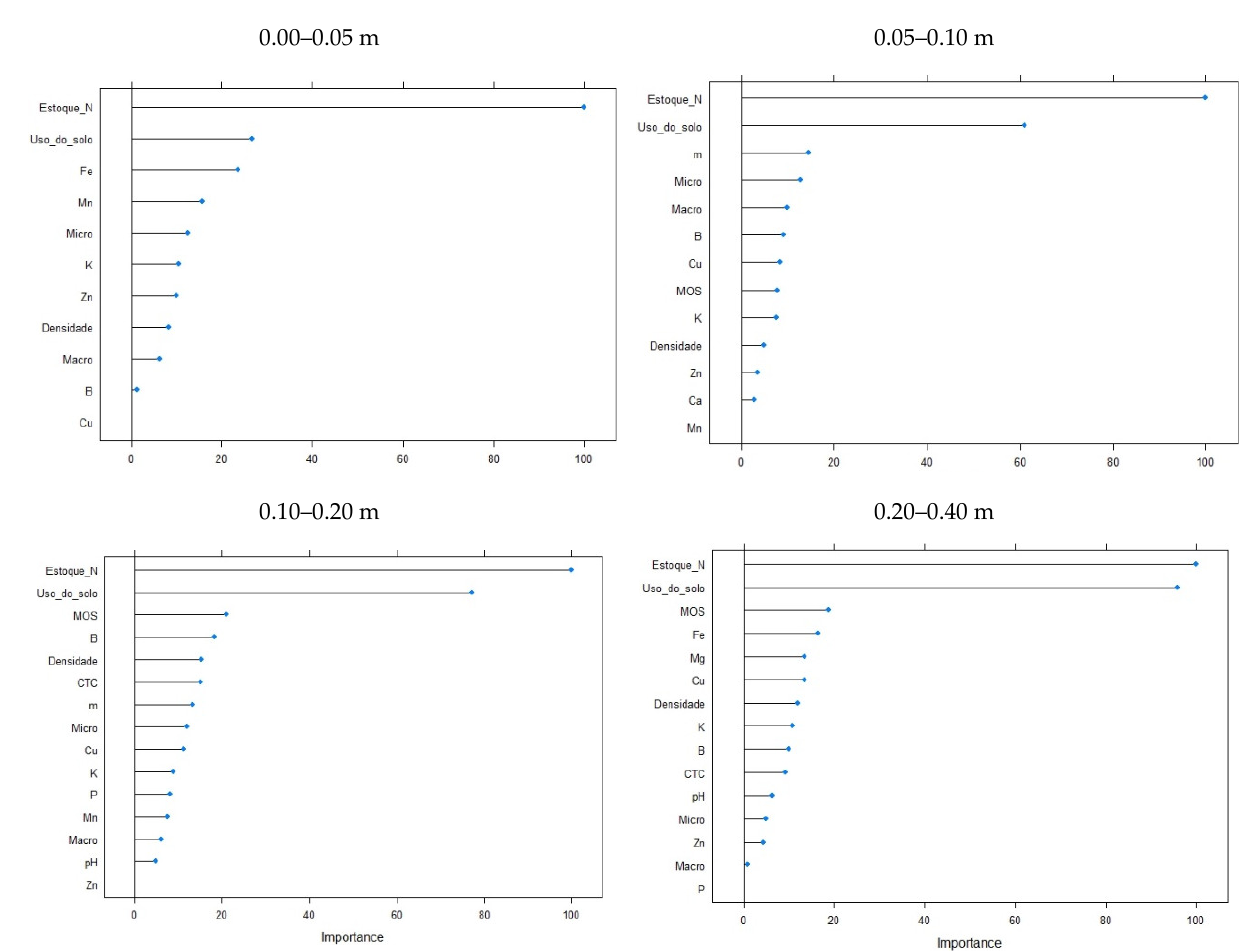
Figure 7. Relative importance of soil physical and chemical variables used to predict soil carbon stock using the Random Forest model: Bd—bulk density (kg dm −3 , Macro—macroporosity (m 3 m −3 ), Micro—microporosity (m 3 m −3 ), SOM—soil organic matter (g dm −3 ), pH—potential hydrogen, P—available phosphorus content (mg dm −3 ), K—potassium content (mmol c dm −3 ), Ca—calcium content (mmol c dm −3 ), Mg—magnesium content (mmol c dm −3 ), m—saturation by aluminum (mmol c dm −3 ), CEC—cation-exchange capacity (mmol c dm −3 ), B—Boron content (mg dm −3 ), Cu—copper content (mg dm −3 ), Fe—iron content (mg dm −3 ), Mn—manganese content (mg dm −3 ), Zn—zinc content (mg dm −3 ), and N Stock—Nitrogen stock (mg dm −3 ).